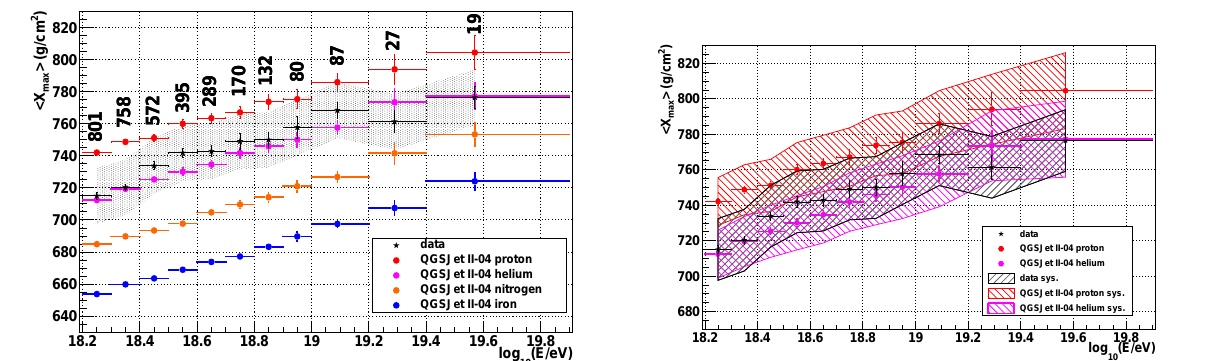
Figure 3: BR / LR hybrid observed and predicted (cid:104) X max (cid:105) for four di ff erent chemical elements. The number of data events for energy bin are also shown.